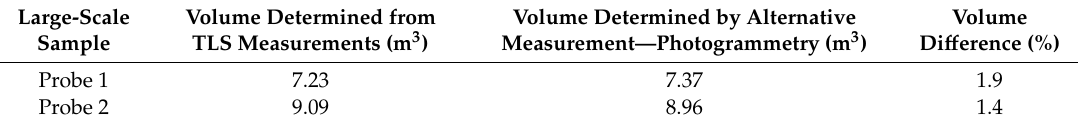
Table 3. Volumes of large-scale samples 1 and 2 determined from TLS and photogrammetric